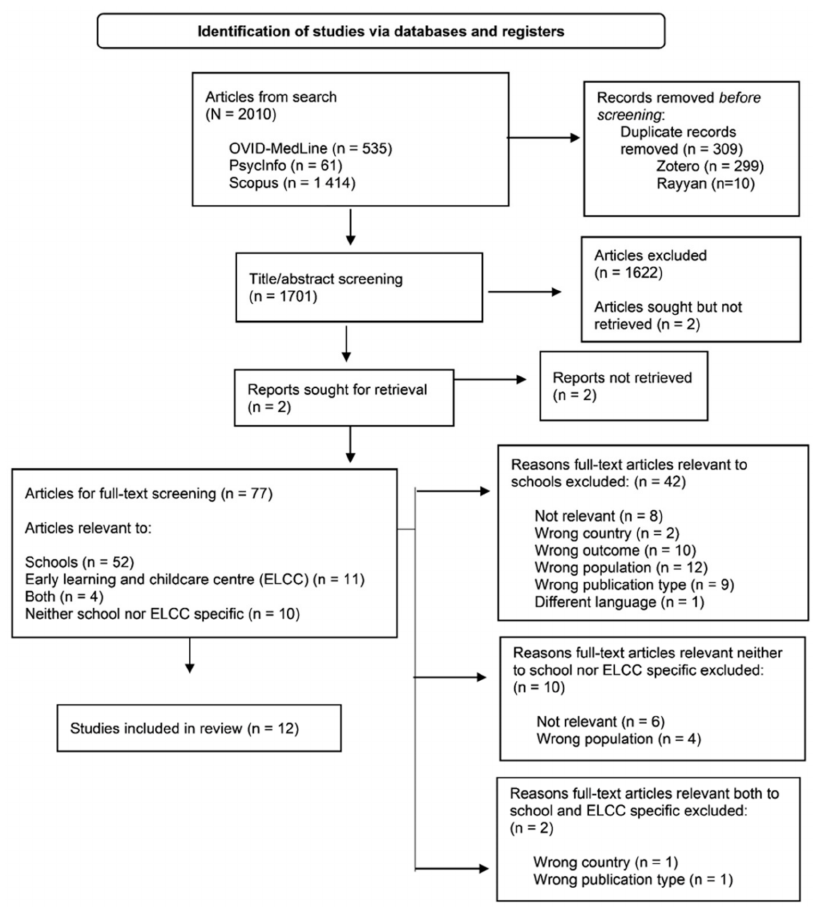
Figure 1. PRISMA flow diagram depicting the selection process articles and reports in the current scoping